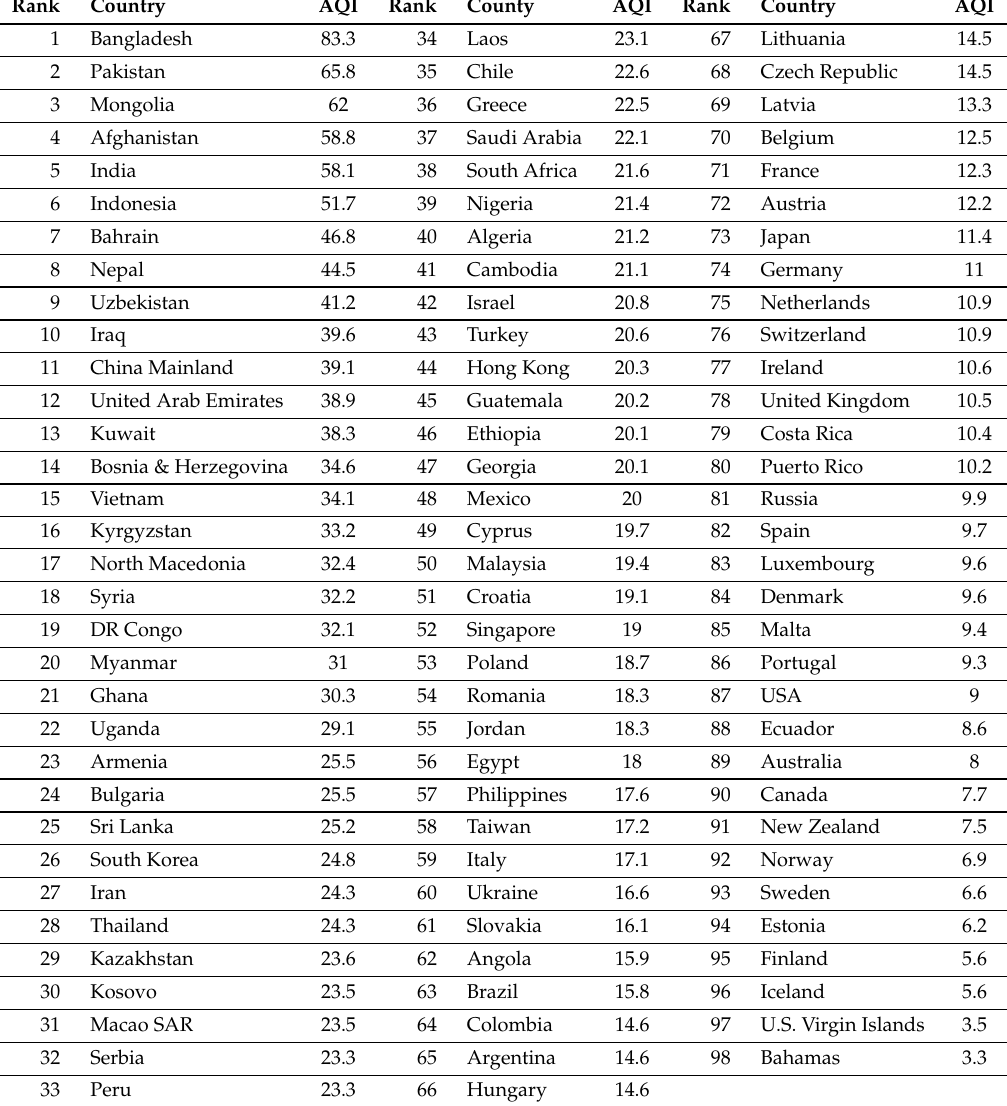
Table 8. Air pollution world country index arranged by average PM2.5 concentration ( µ g/m 3 ), weighted by population. Source: IQAir, 2019 World Air Quality Report